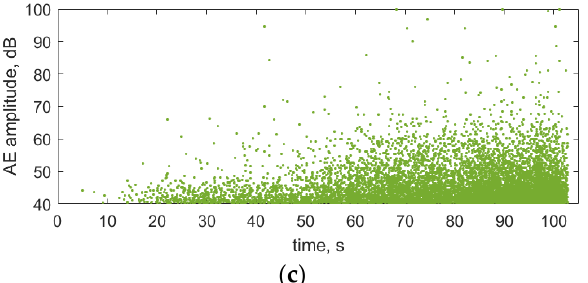
Figure 4. Time dependence of the maximum amplitude of AE pulses registered during the quasi-static uniaxial tension of woven laminate samples (warp ( a ), weft ( b )) and unidirectional CFRP samples ( c ) (a single point corresponds to a single pulse).